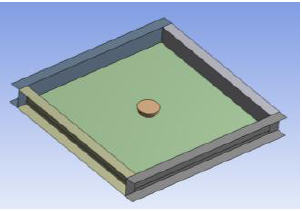
Fig.14 Model used for simulation